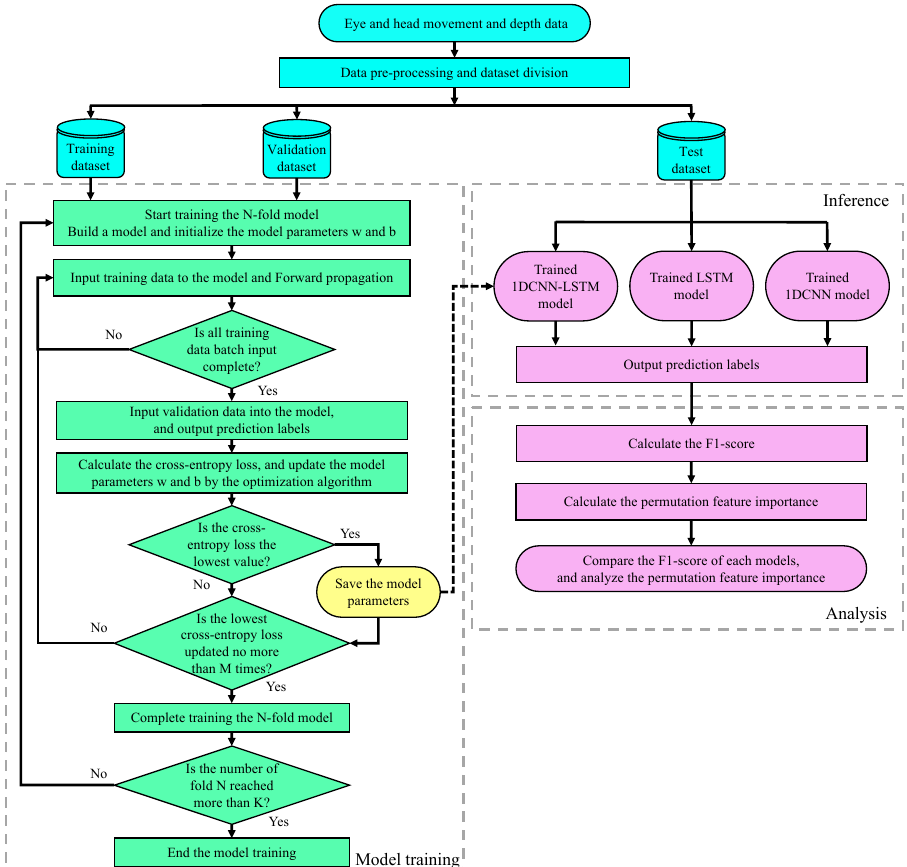
Figure 7. Flowchart of the visual intention estimation